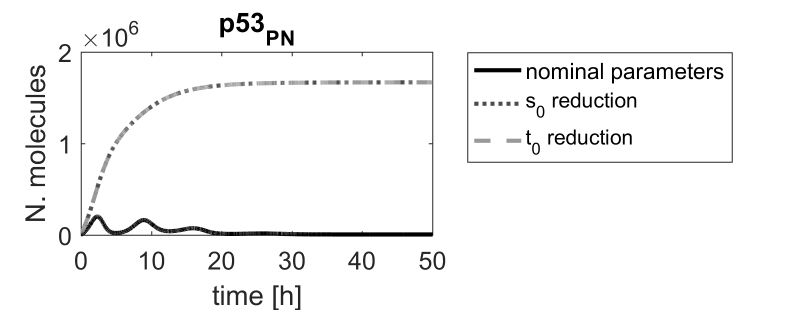
Figure 3. Comparison of p53 protein responses in the model with nominal parameters (black line) and parameters s 0 , t 0 reduced by α = 0.15 (gray dashed lines).